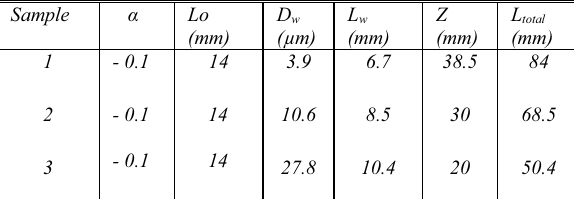
Table 1. Tapers parameters, model and experiments